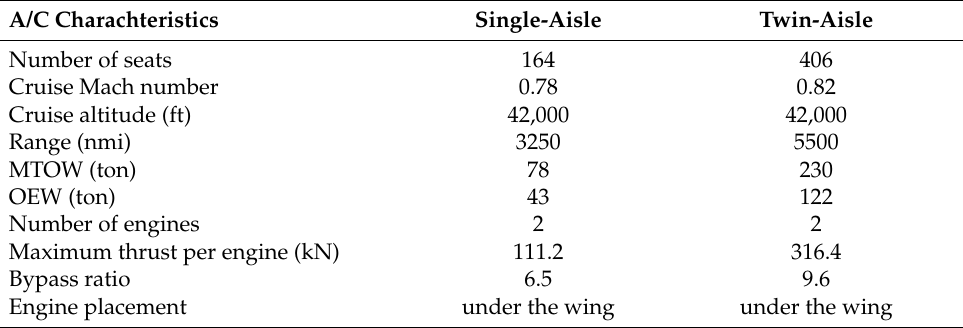
Table 1. Main characteristics of the single- and twin-aisle aircraft.